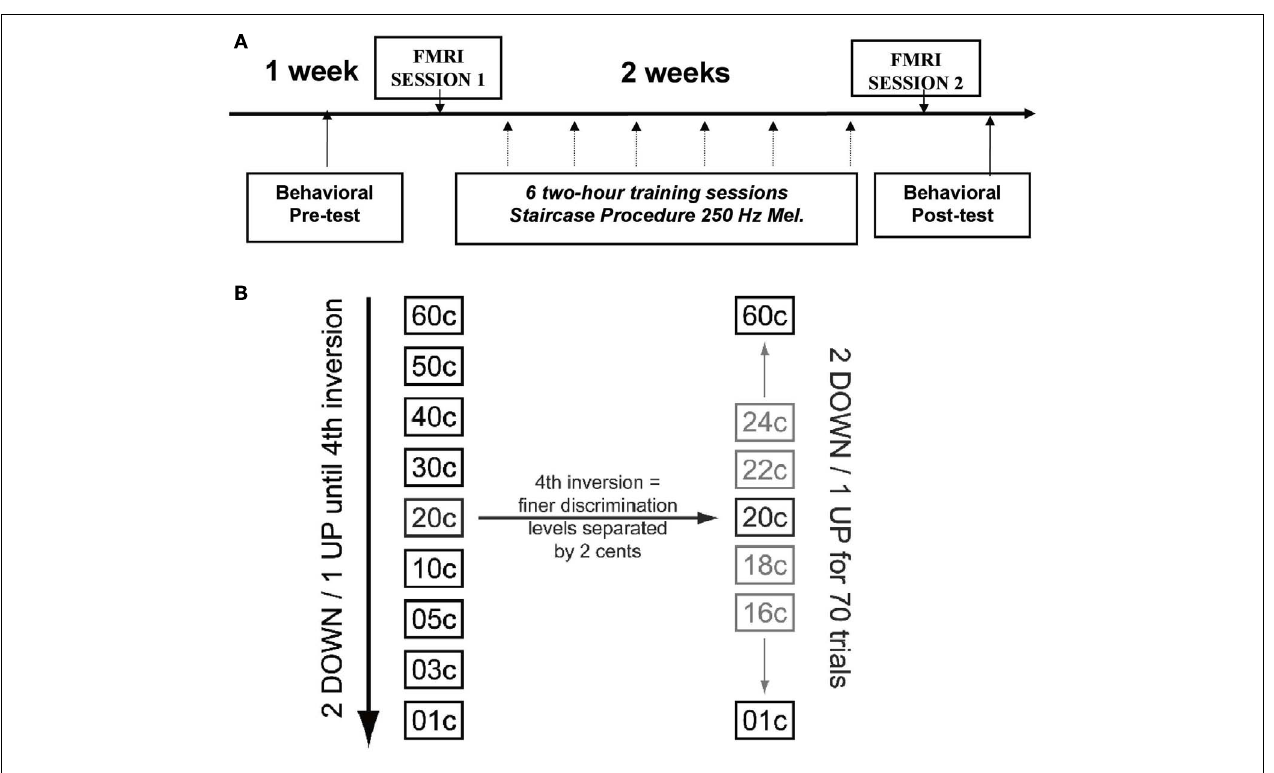
spacing of pitch intervals) during the first part of the procedure, until the fourth reversal was achieved; subsequently the stimuli were chosen from the more finely spaced stimuli (2cents difference) indicated in the right